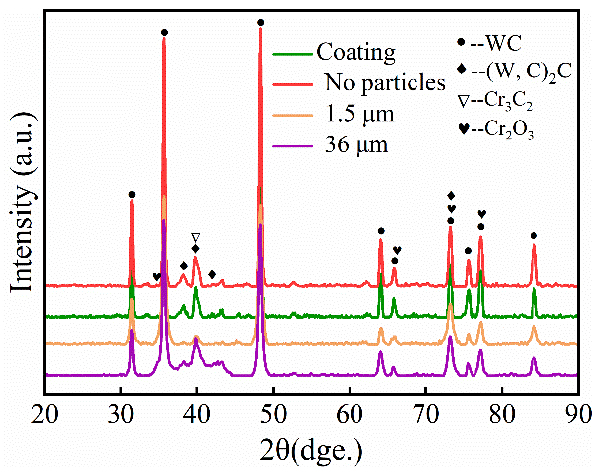
Figure 9. XRD patterns of coating wear scar micro−domains .